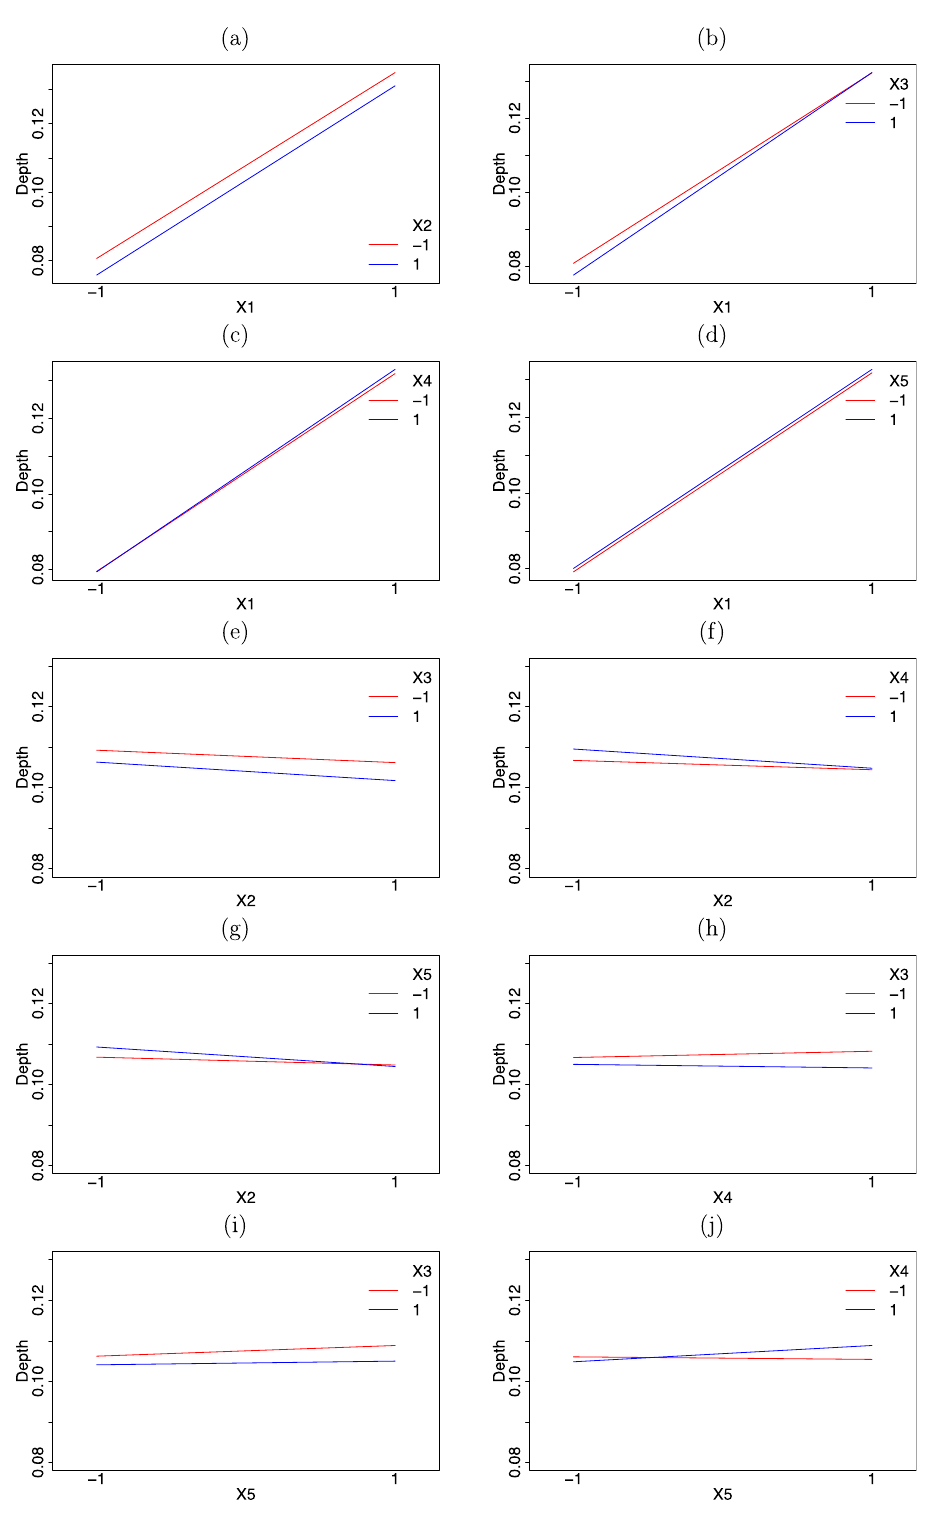
Fig. 2 Interaction plots with the melt pool depth on the Y-axis and an input factor on the X-axis. a Interaction effect of P A (cid:1) λ . b Interaction effect of P A (cid:1) μ . c Interaction effect of P A (cid:1) γ . d Interaction effect of P A (cid:1) (cid:3) d γ = dT . e Interaction effect of λ (cid:1) μ . f Interaction effect of λ (cid:1) γ . g Interaction effect of λ (cid:1) (cid:3) d γ = dT . h Interaction effect of μ (cid:1) γ . i Interaction effect of μ (cid:1) (cid:3) d γ = dT . j Interaction effect of γ (cid:1) (cid:3) d γ = dT (cid:1) (cid:3) interactions involved with P A are much larger than that of other 2-factor interactions are shown The interaction plots for all 5 2 in Fig. 2, where the fi ve input factors: ( P A , λ , μ , γ , − d γ /d T ), are factors, which is expected since the dominating in fl uence of P A has already been established. The P A (cid:1) λ interaction is not denoted by ( X 1 , X 2 , X 3 , X 4 , X 5 ), respectively for ease of representation. We fi rst observe that the magnitude of signi fi cant, as seen from the two parallel lines in Fig. 2a. Hence